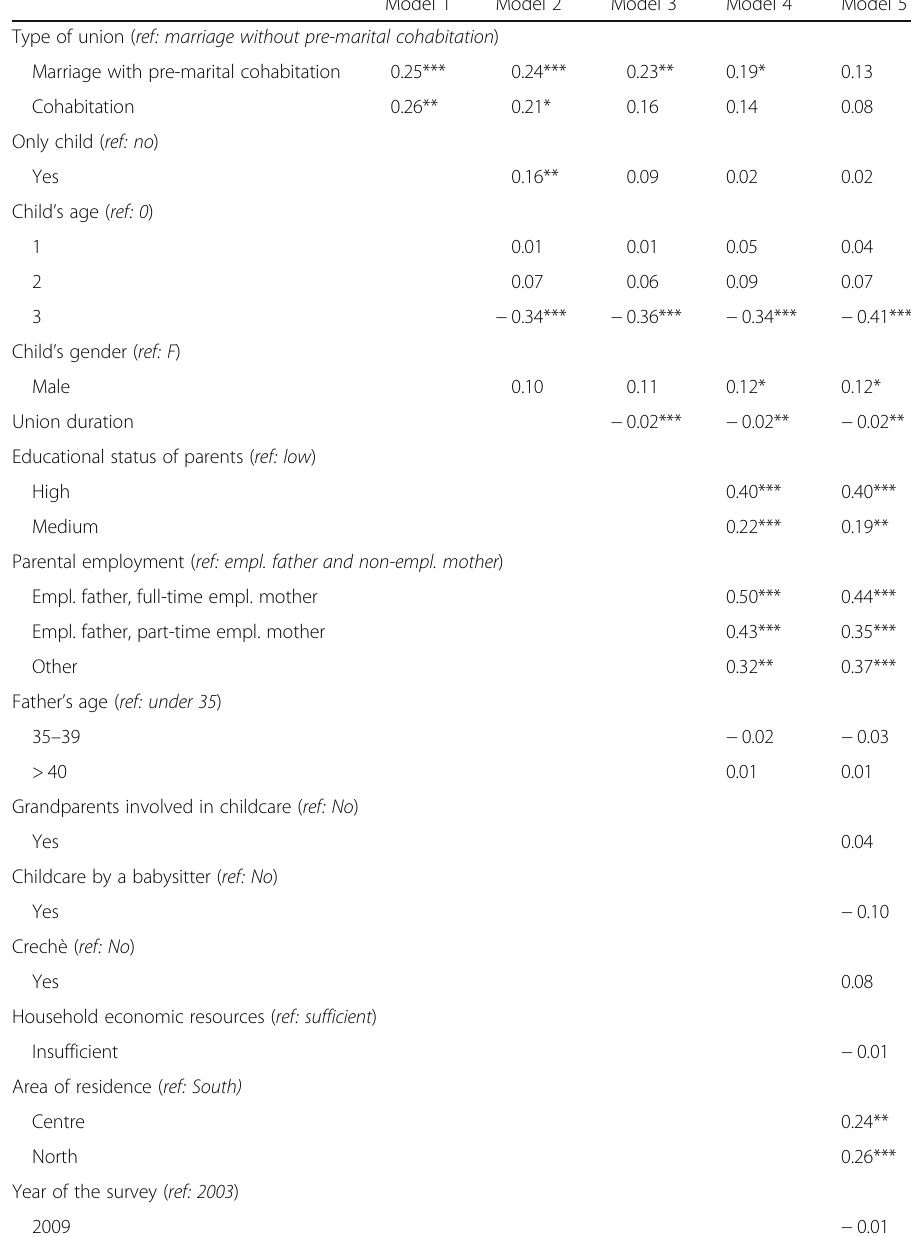
Table 2 Ordinal logistic models for fathers ’ involvement in daily basic childcare as a whole — β coefficients (coefficients predicting higher involvement of fathers — 3093